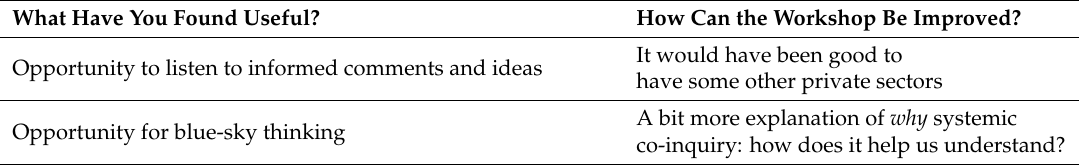
Table 4. Participants’ responses to workshop evaluation questions